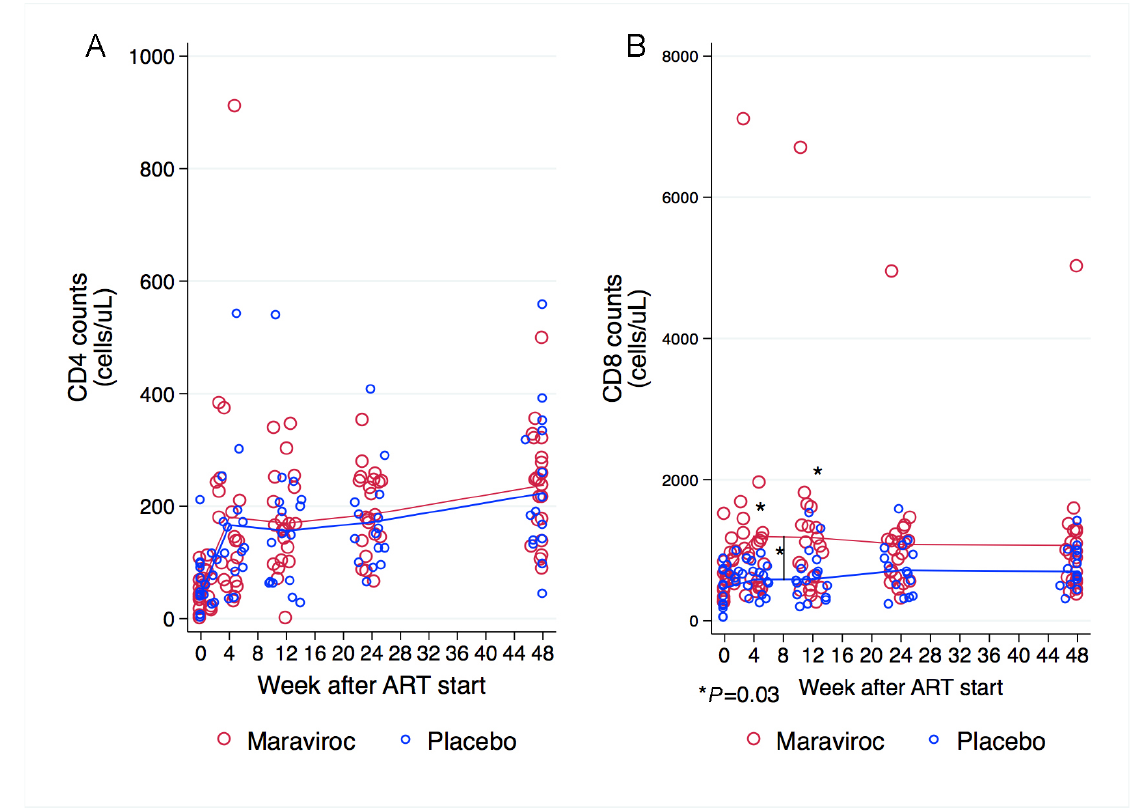
Figure 1. CD4+ and CD8+ cell counts at baseline, and weeks 4, 12, 24, and 48. (A) Baseline CD4+ cell counts and changes over time were similar for both groups. (B) Participants receiving maraviroc had a sig- nificantly , greater increase in CD8+ cell counts during the first 12 weeks and mean CD8+ cell counts were significantly higher at week 4 and 12. The scale of the Y-axis differs in the panels. Comparisons at each time point are indicated when P <0.05. The P -values were derived from mixed linear models using linear combination of coefficients after model